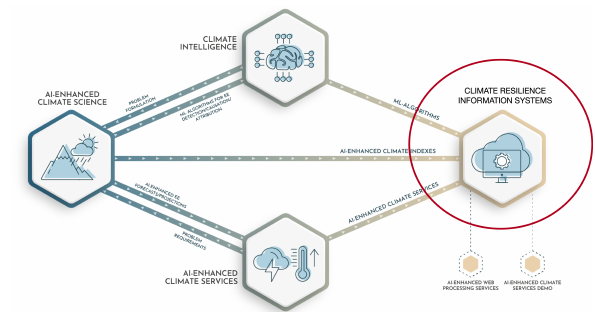
Figure 1. Scheme of the CLINT project. Developed AI enhanced services are being prepared for deployment in CRIS. Source (modified):